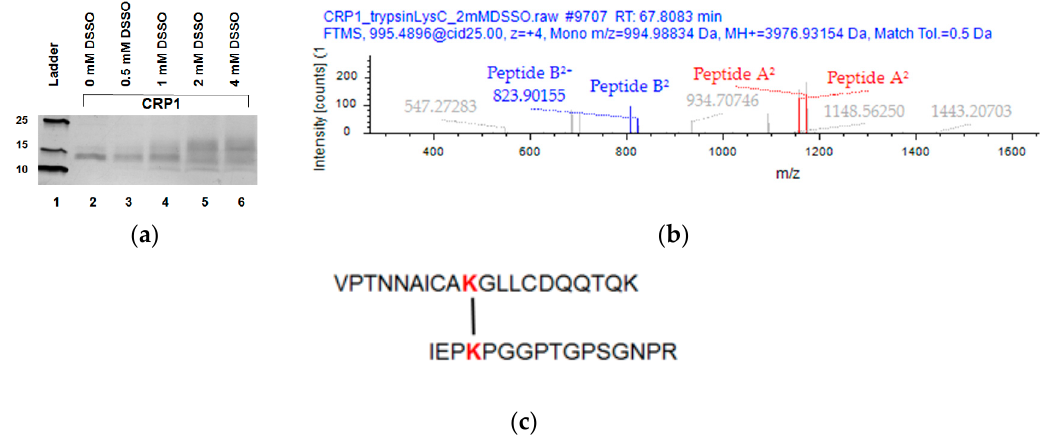
Figure 6. Cross-linking mass spectrometry (XL-MS) experiments with recombinant CRP1 treated with DSSO reveals one intramolecular cross-linked product between residues K53 and K75. ( a ) SDS-PAGE analysis of purified recombinant CRP1 treated with increasing concentrations of DSSO. Proteins were visualized by silver staining ( b ) MS/MS spectrum of the precursor ion containing the intramolecular cross-linked peptides (signature ion pairs are shown as red and blue lines). ( c ) CRP1 intramolecular DSSO-cross-linked peptides and their corresponding sequences.